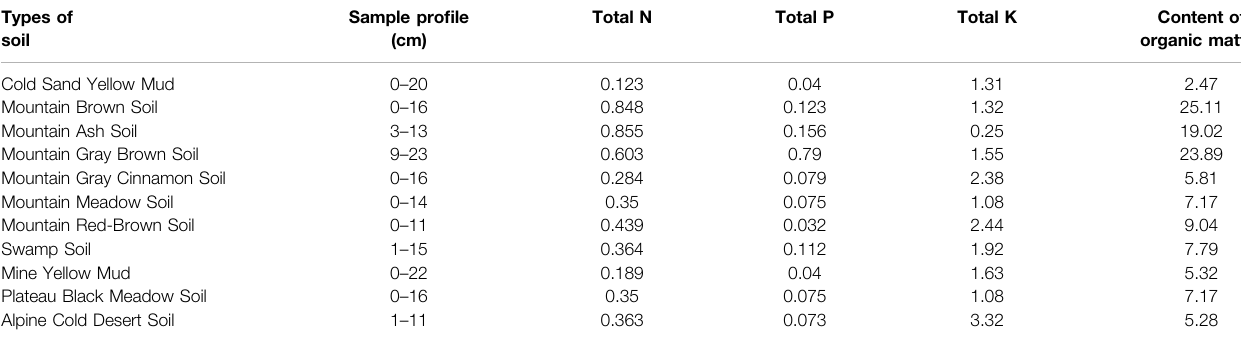
Sample pro fi le (cm)